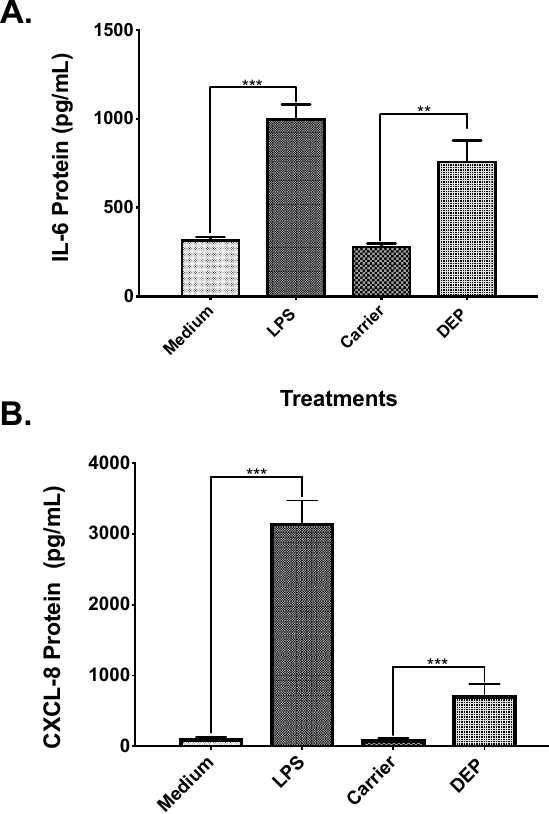
Figure 1. Validation of the experimental conditions. A total of 5.0 × 10 4 BEAS-2B cells were seeded on 96-well plates. Positive control cells were exposed to 10 µg/mL of lipopolysaccharides (LPS), negative controls cells were exposed to Keratinocyte Basal Medium-2 (KGM-2), carrier cells were exposed to 0.1% dimethyl sulfoxide (DMSO) diluted in KGM-2 and diesel exhaust particles (DEP) cells were exposed to 10 µg/mL of DEP organic extract. Interleukin-6 (IL-6) release ( A ) and interleukin-8 (CXCL8) release ( B ) were measured from cell supernatants after 24 h of exposure. Values are expressed as the mean ± SEM ( n = 3). ** p ≤ 0.01 *** p ≤ 0.001 compared to negative control.